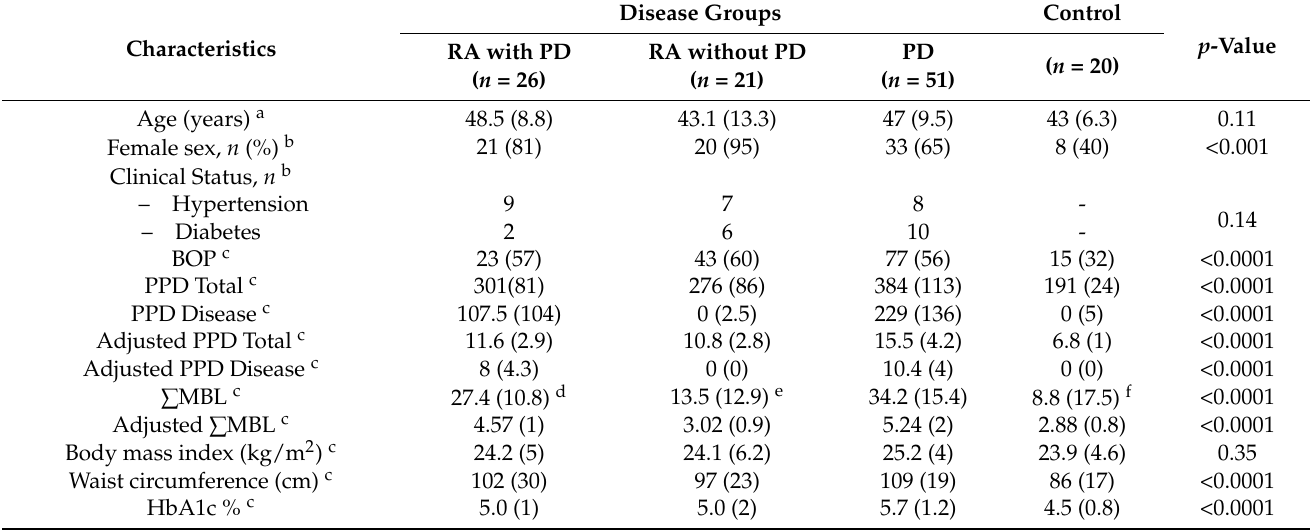
Table 1. Characteristics for RA and PD (disease) groups and